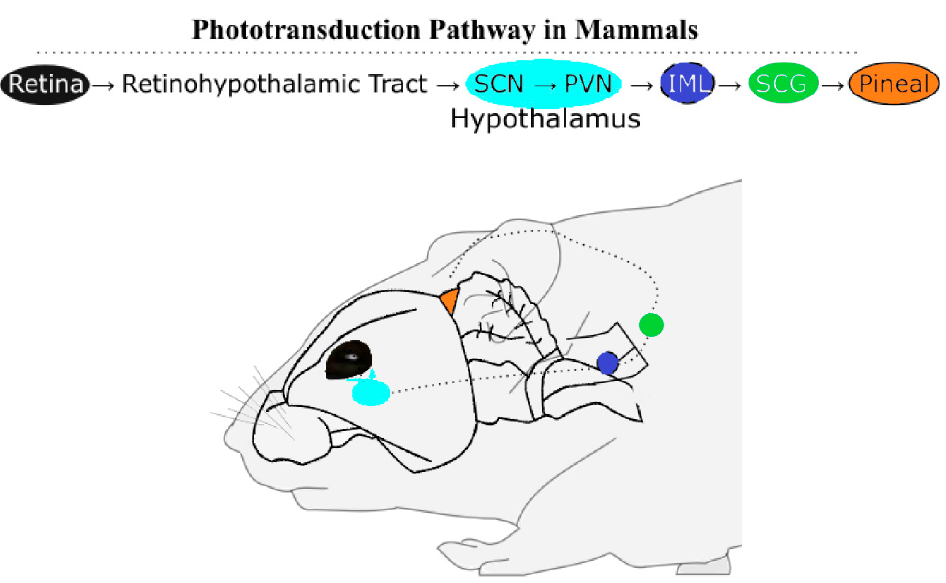
Figure 1. Phototransduction pathway in mammals. Light is detected by the retina. Photic information is transduced via the retinohypothalamic tract to nuclei in the hypothalamus. The suprachiasmatic nucleus (SCN) projects to the paraventricular nucleus (PVN), which synapses in the superior cervical ganglion (SCG). The signal is transmitted from the SCG to the Pineal.